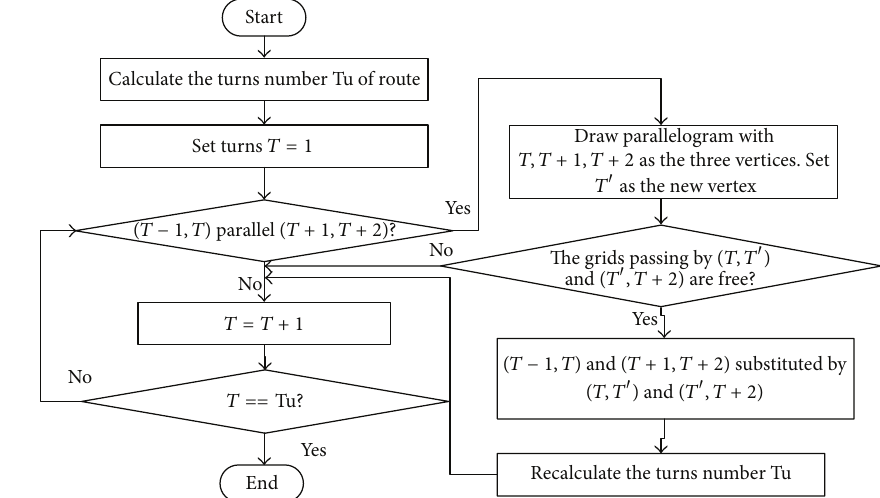
Figure 9: Flow chart of reducing turns by parallelogram.